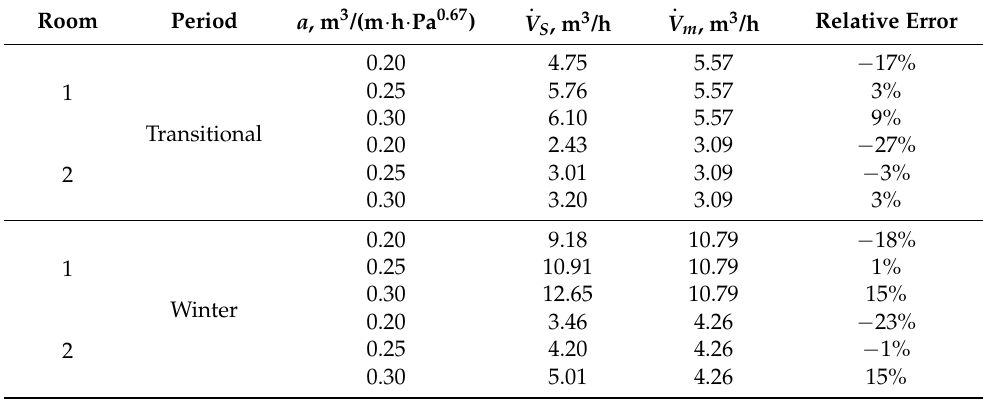
Table 2. Comparison of airflow results for simulation and